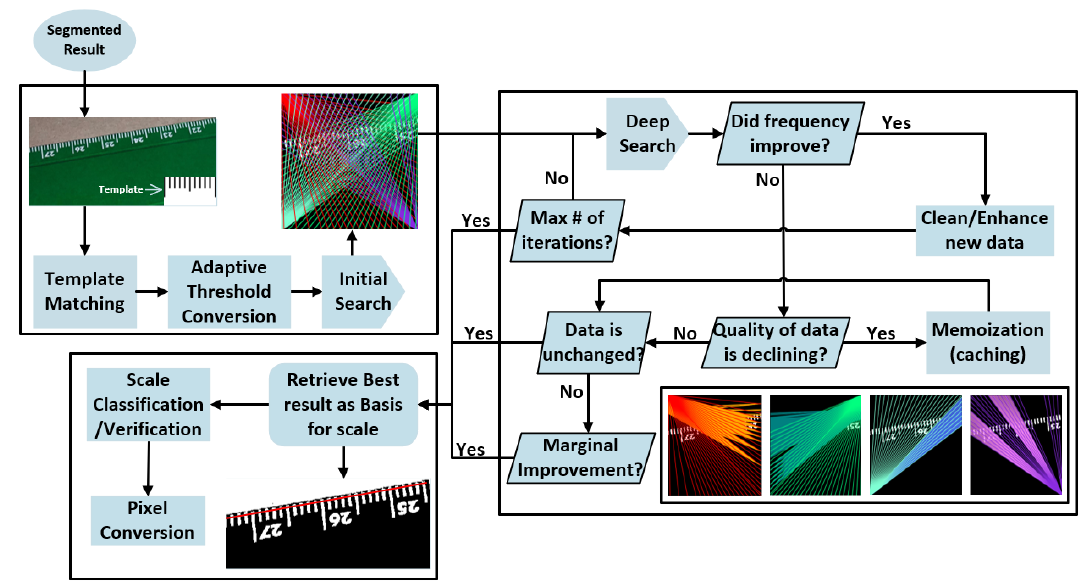
Figure 1. High Level Architecture proposed heuristic method for scale calibration (best seen in